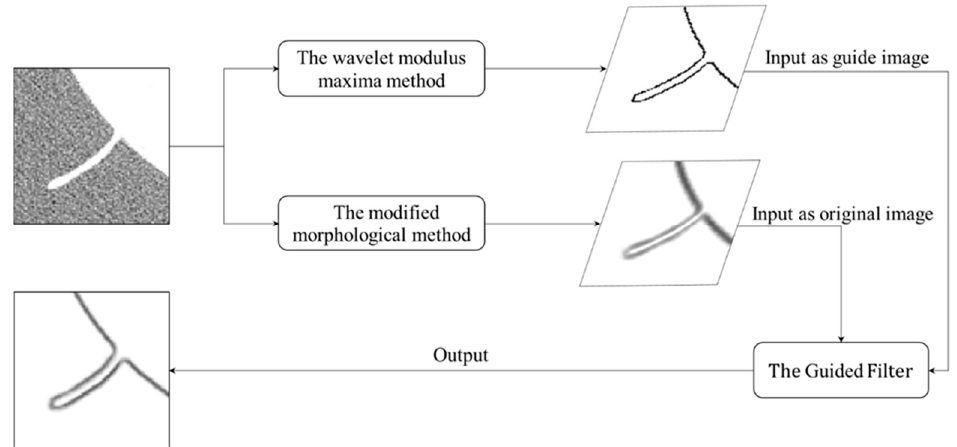
Figure 2. The guided filter-based algorithm flow.